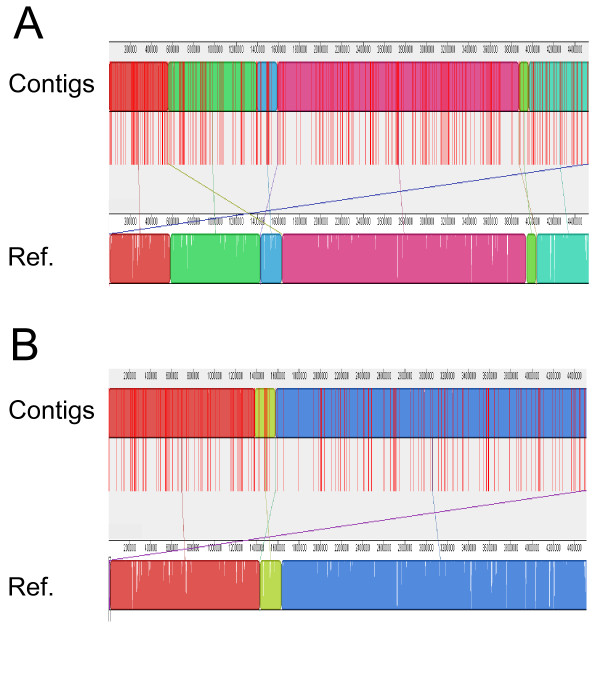
Visualizing alignments of contigs. Contigs of assembled E. coli MG1655 reads from the uncorrected (top) and J48 corrected (bottom) overlaps were mapped to the MG1655 genome using SNAPPER and ordered in respect to their position. MAUVE was used to visualize alignments of assembled contigs to the reference genome. Each segment represents a matching alignment between the contigs and reference genome. There may be more than one segment per contig. Red vertical lines represent contig boundaries. Colored blocks represent regions where contigs are in the correct order. Colored lines connect corresponding blocks between the reference genome and the assembled contigs. White spaces within the blocks within the reference genome indicate regions not represented within a contig.